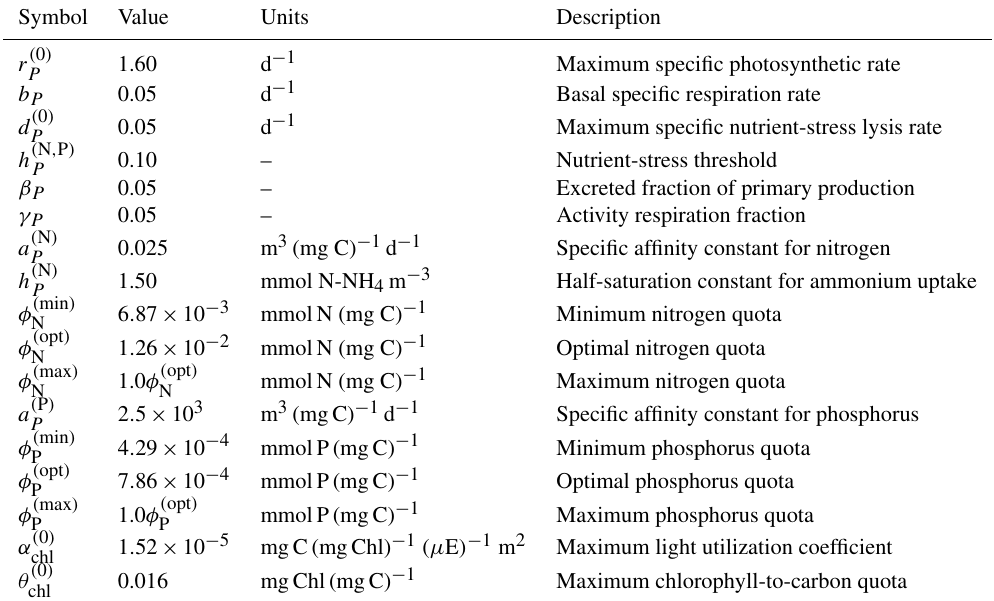
Table A3. Phytoplankton parameters, values, units, and descriptions within the BFM17 pelagic model. Symbol Value Units